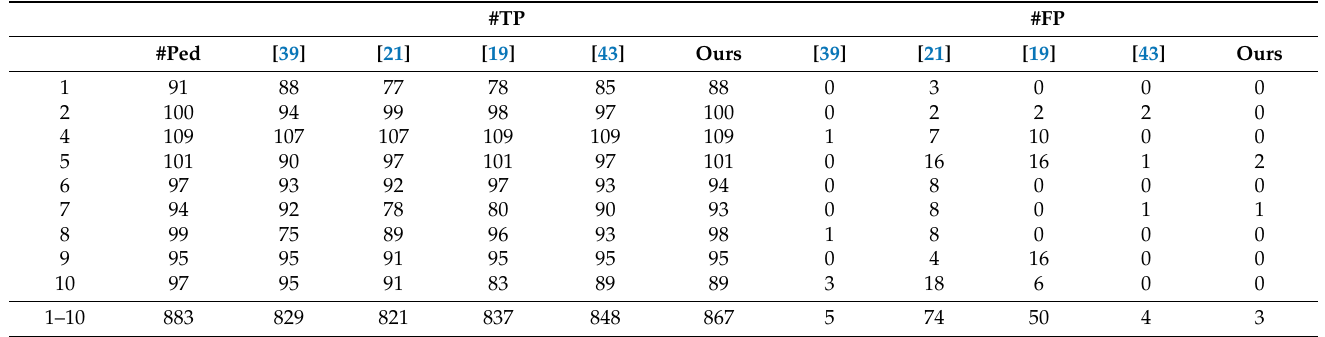
Table 3. Comparison of TP and FP values of the proposed method with other